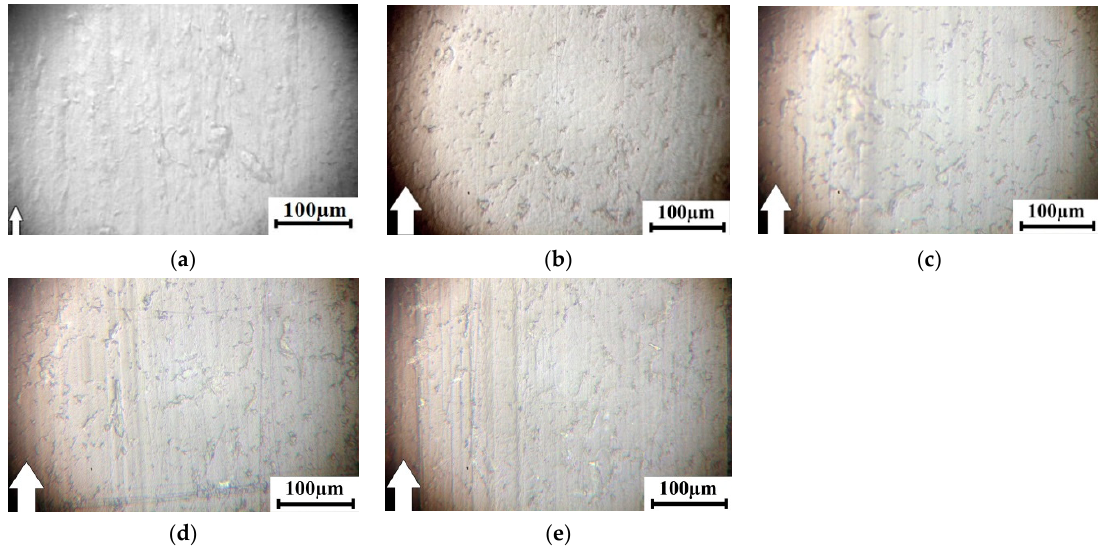
Figure 9. Optical images of the wear track surfaces of neat UHMWPE ( a ); and the “UHMWPE + 15 wt. % wollastonite” composites: untreated ( b ); “KH-550” ( c ); “Penta-1006” ( d ); and “OTS” ( e ) (Load = 60 N, Velocity = 0.3 m ∙ s − 1 ).